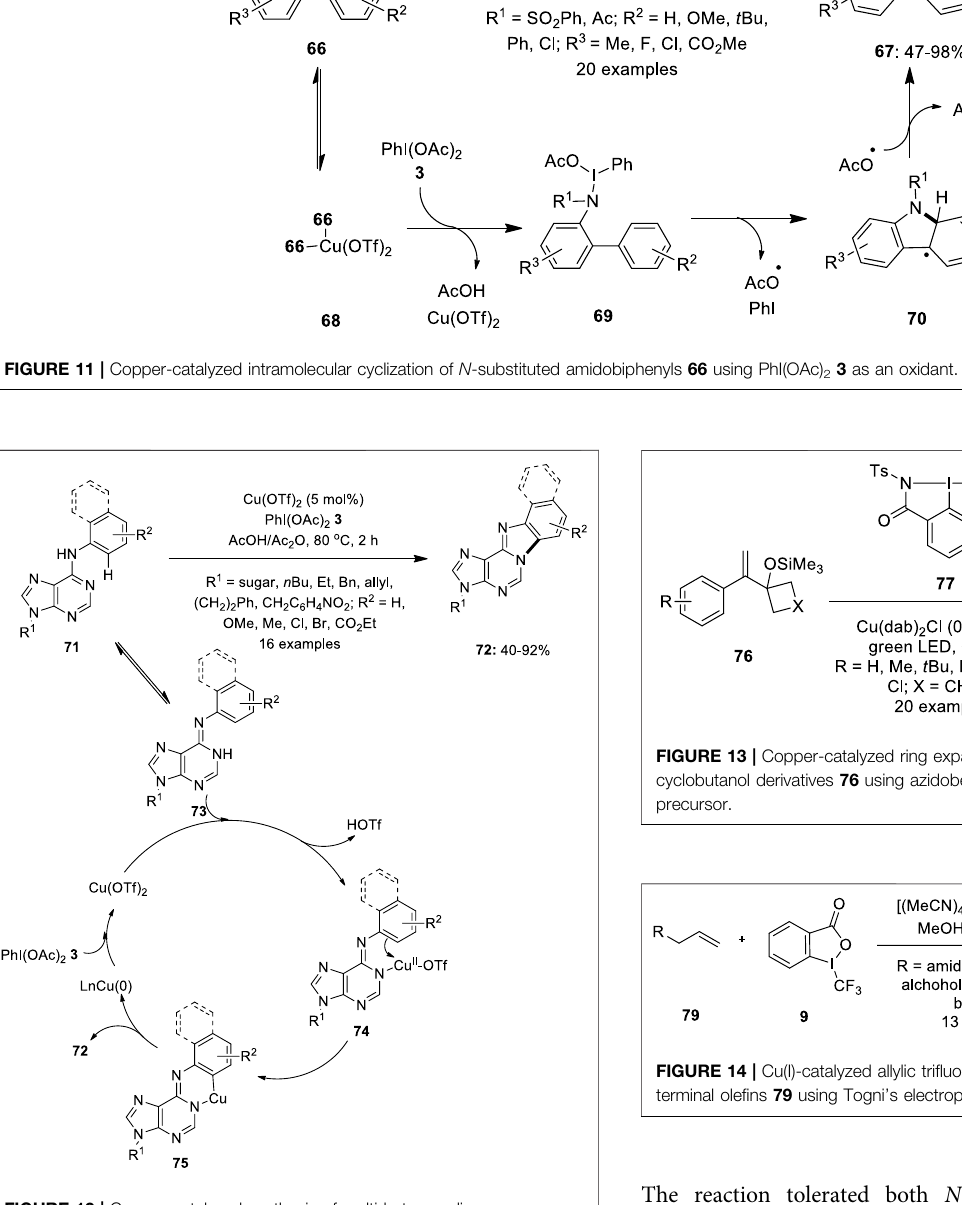
FIGURE 12 | Copper-catalyzed synthesis of multi-heterocyclic compounds 72 from 6-anilinopurine nucleosides 71 using PIDA 3 as an oxidant.